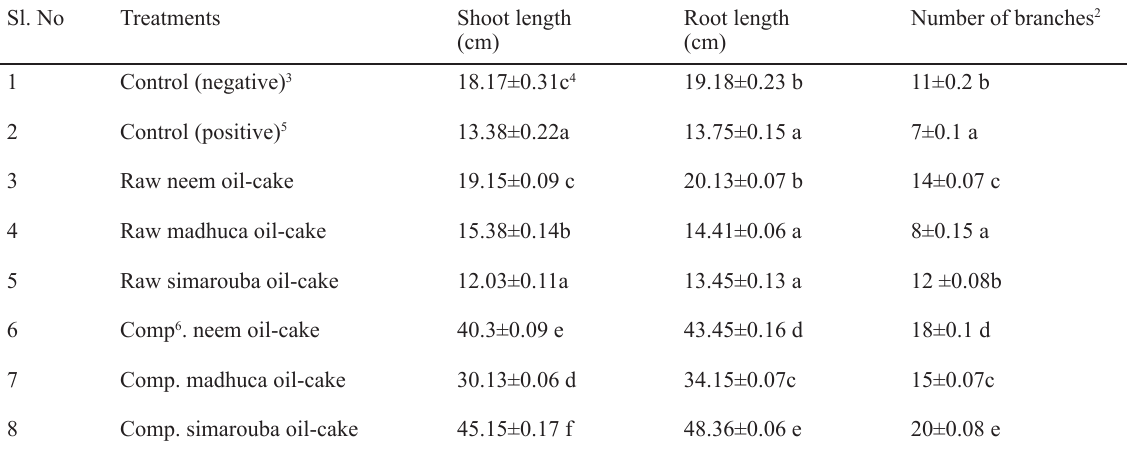
Table 2 Effect of amendment of soil with raw and composted oil-cakes of neem, madhuca and simarouba on the shoot and root length and number of branches in 3-week-old chilli plants in the greenhouse 1